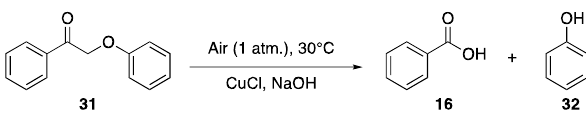
Table 3. Scope of the